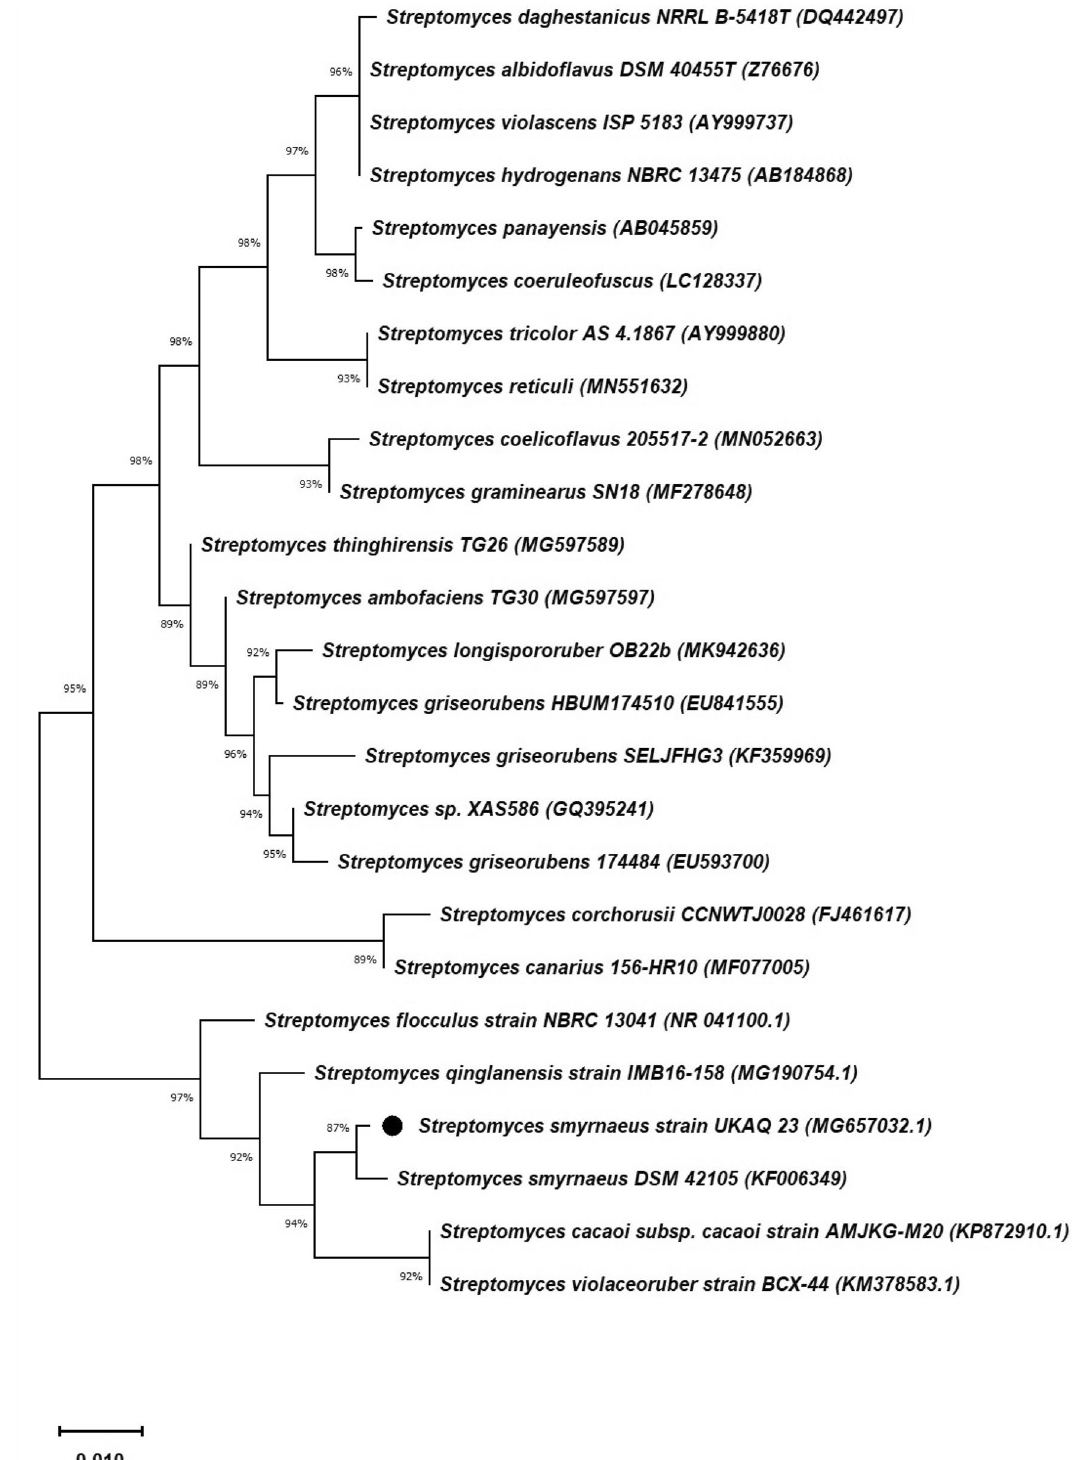
Figure 2. Neighbor-joining (NJ) phylogenetic tree of strain UKAQ_23 based on 16S rRNA gene sequencing generated by MEGA-X. The numbers at branch nodes indicate levels of bootstrap support (%) based on neighbor-joining analysis of 1520 resampled datasets. The NCBI accession numbers are given in parentheses. The bar scale, 0.01, represents the nucleotide substitutions per